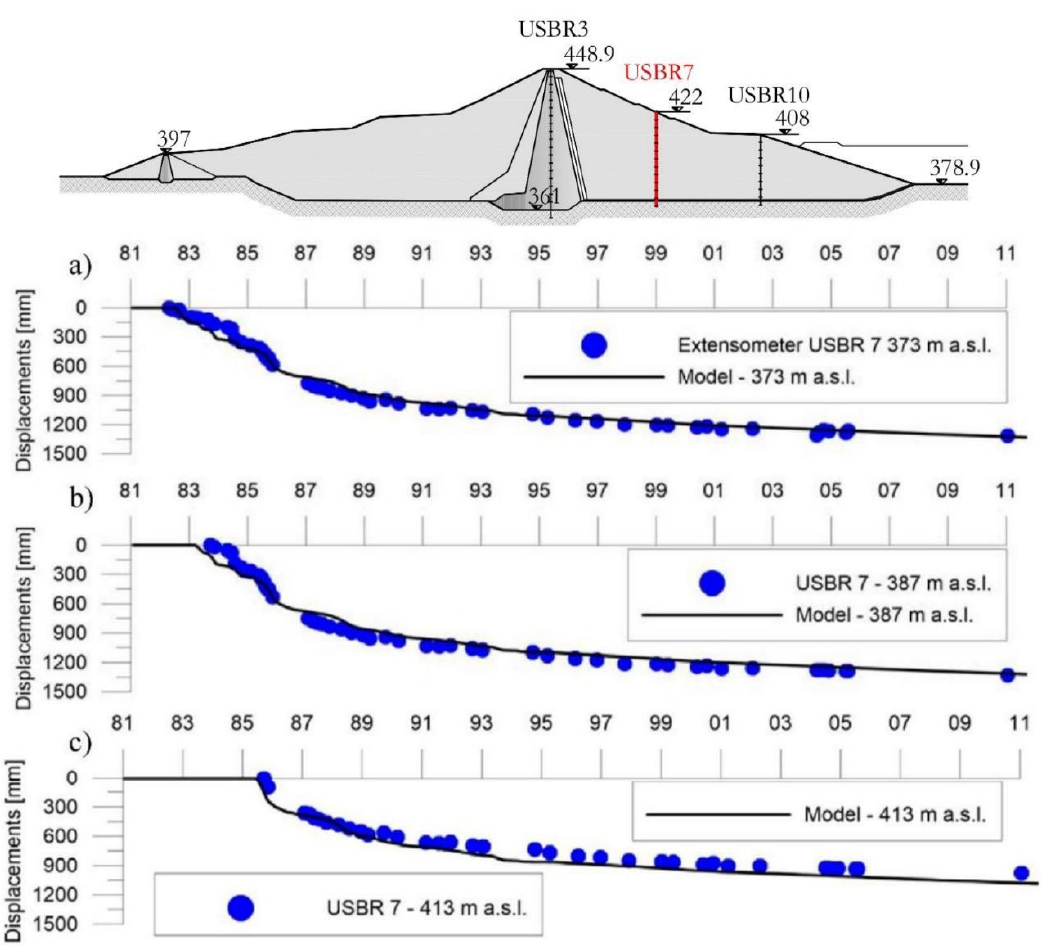
Figure 29. Comparison between extensometer measured displacement and model obtained displacement for USBR 7 at different heights: ( a ) 366 m a.s.l.; ( b ) 381 m a.s.l.; ( c ) 413 m a.s.l.